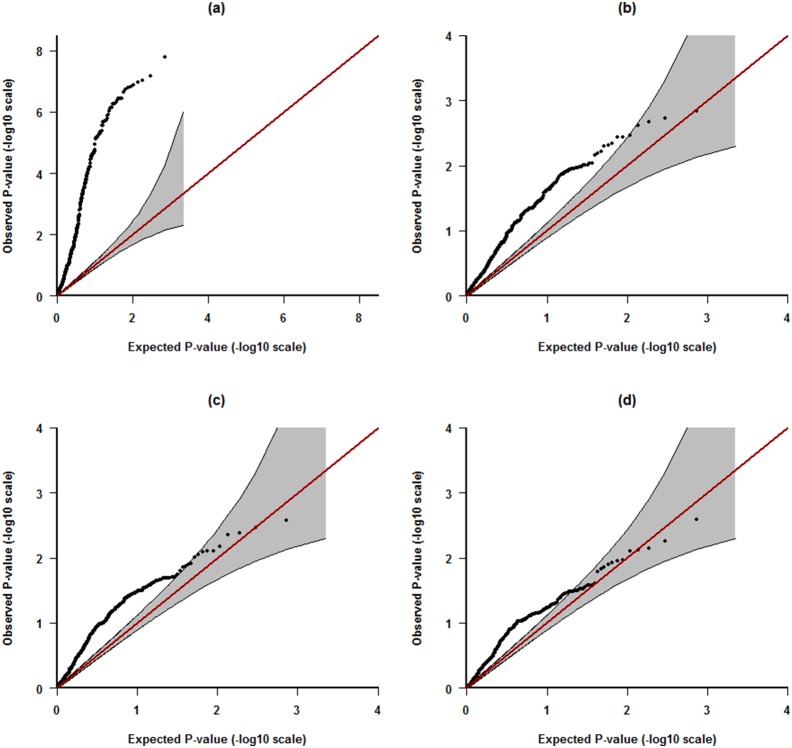
–log10 QQ plots for p-values assessing the association between the investigated features (Table S1 and APs) and rs10995190.(a) with adjustment for age, BMI, menopausal status, HRT use, parity and age at first birth. (b) with adjustment as in (a), plus Volpara. (c) with adjustment as in (a), plus CASAM-Vol. (d) with adjustment as in (a), plus CASAM-Area.